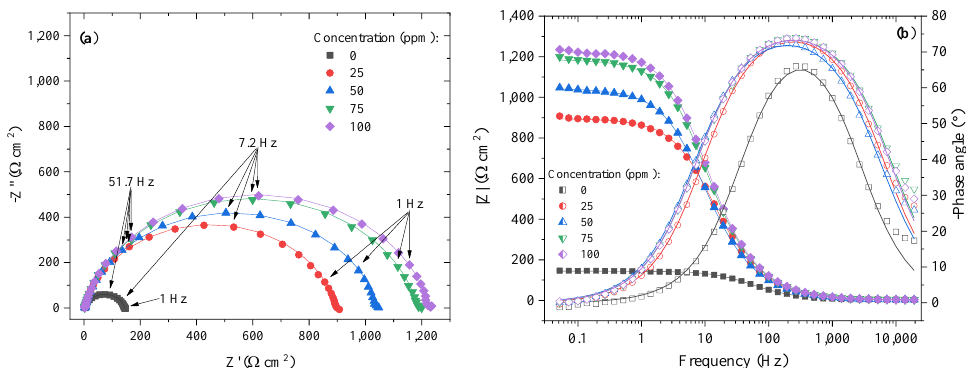
Figure 4. Impedance spectra of API X52 steel in 0.5 M HCl in the absence and presence of [THDA + ][ − AA] at different concentrations: ( a ) Nyquist and ( b ) Bode diagrams.